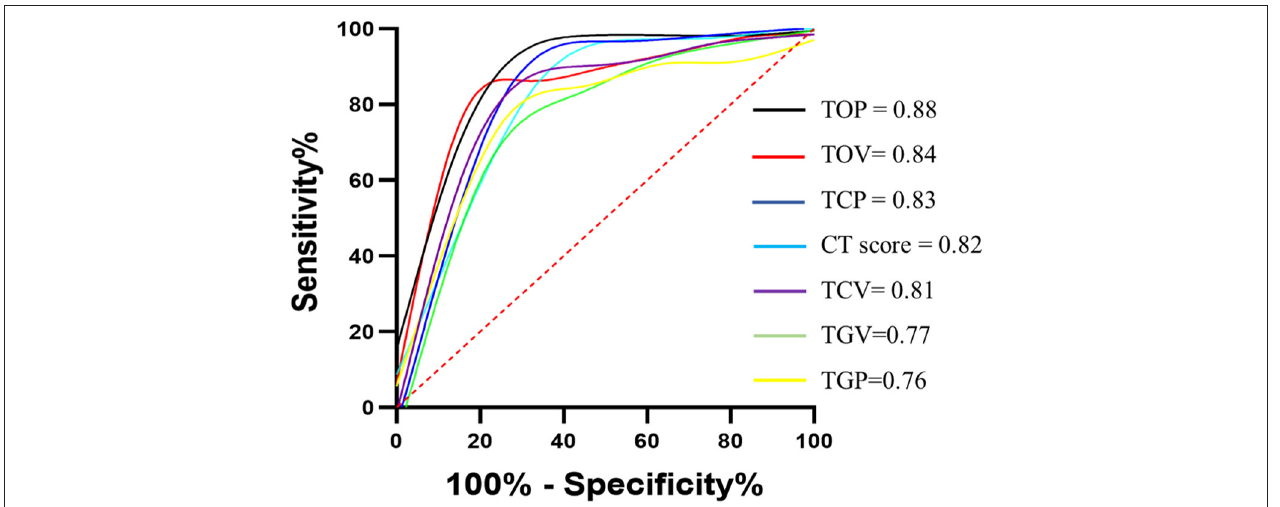
FIGURE 7 | ROC curves for semiquantitative and quantitative parameters. ROC curves for CT score, TCV, TCP, TGV, TGP, TOV, and TOP. 95% CI for confidence intervals for area under curves (AUCs) were shown for CT score (0.73–0.91), TCV (0.74–0.90), TCP (0.74–0.92), TGV (0.66–0.86), TGP (0.67–0.86), TOV (0.77–0.92), and TOP (0.81–0.95). All p < 0.001. TCV, total consolidation volume; TCP, total consolidation percentage; TGV, total round glass opacity volume; TGP, total grand-glass opacity percent; TOV, total opacity volume; TOP, total opacity percentage.